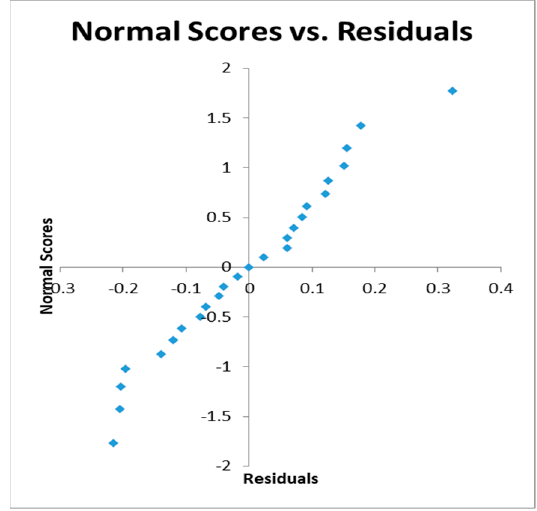
Figure 3. Normal score plots from the simulation experiment.